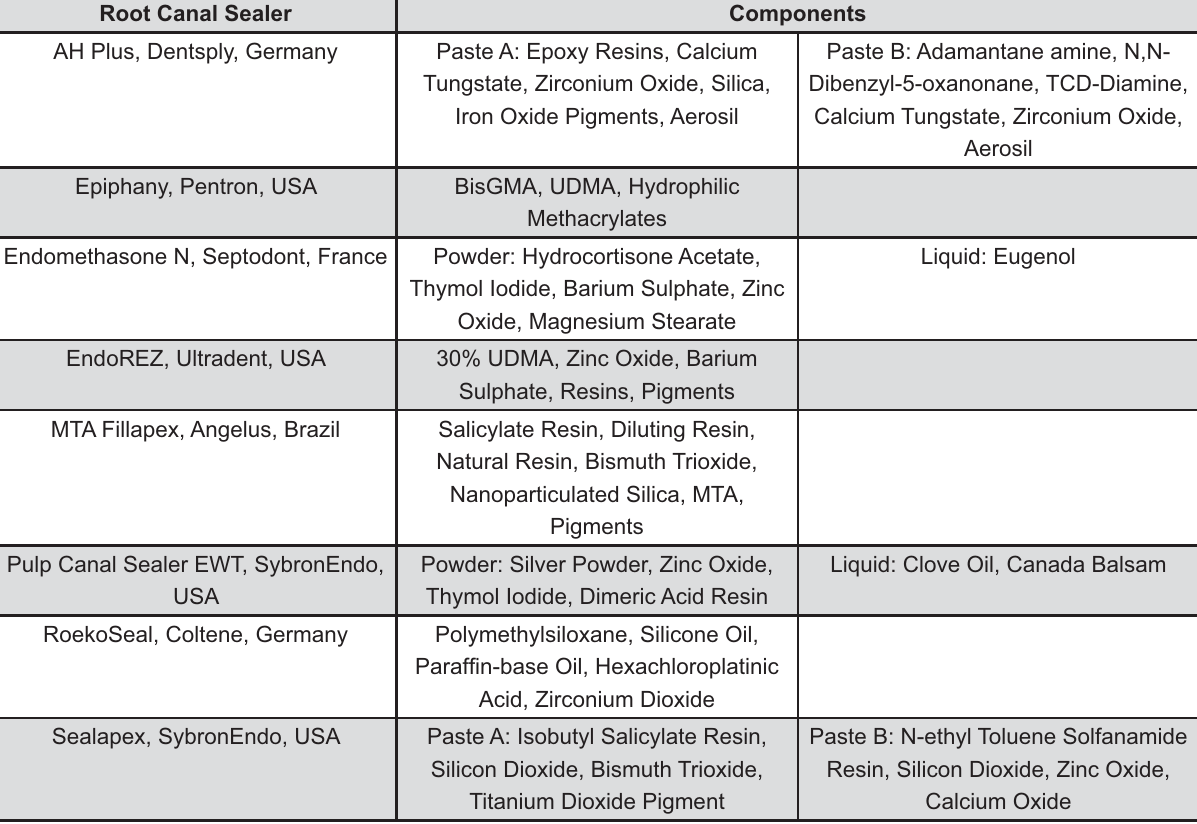
Figure 1- Composition of materials and their